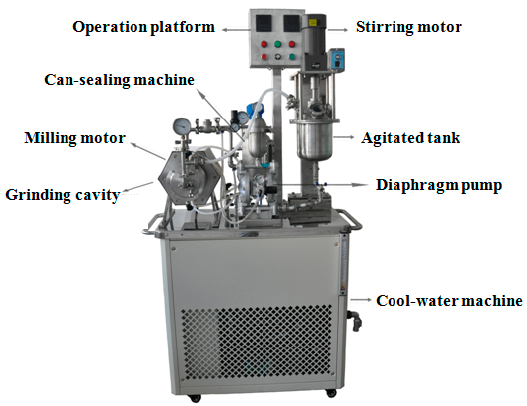
Figure 1. Image of the nano sand-mill.